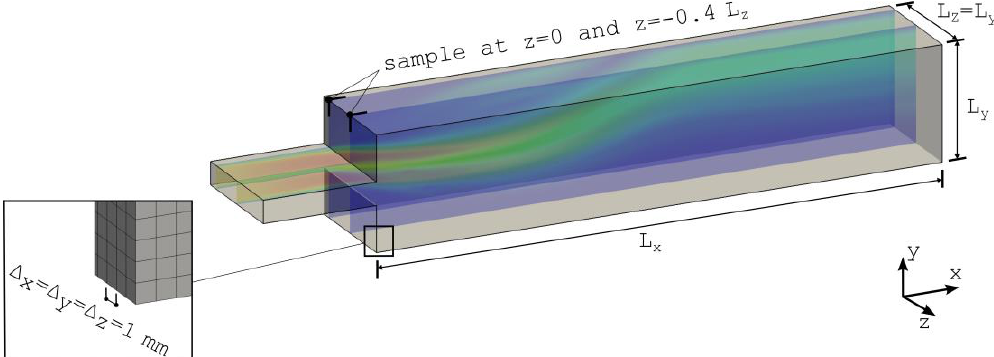
Figure A3. Geometry and grid of 3D calculation.